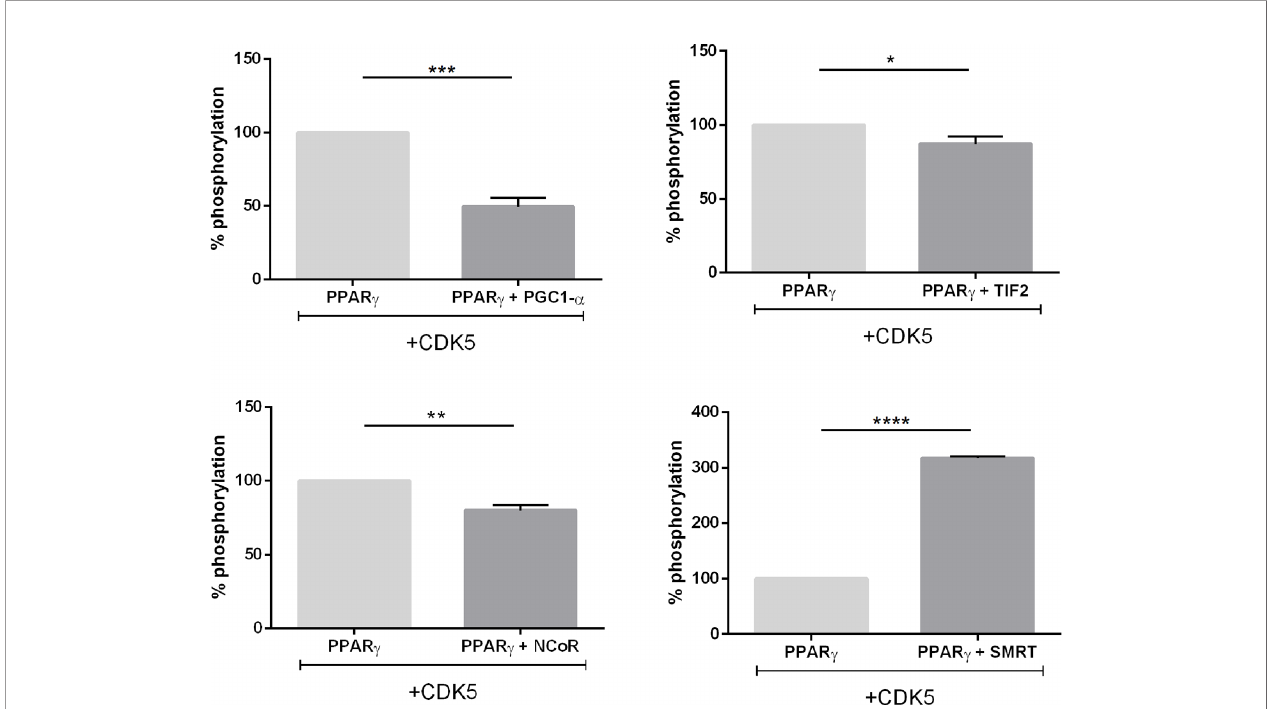
FIGURE 9 | In vitro phosphorylation assay. Luminescence signal produced as consequence of the ADP production in vitro reaction containing CDK5/p35 kinase, ATP and PPAR g , and the complexes with coregulators. All the luminescence signals were normalized by PPAR g condition which is 100% of phosphorylation. Error bars, SEM, (n = 3). Statistical analysis: one-way ANOVA. P values: p ≤ 0.05*; p ≤ 0.01**; p ≤ 0.001***; p ≤ 0.0001****. The complex PPAR g + SMRT presented increased luminescence while the other three complexes presented decreased